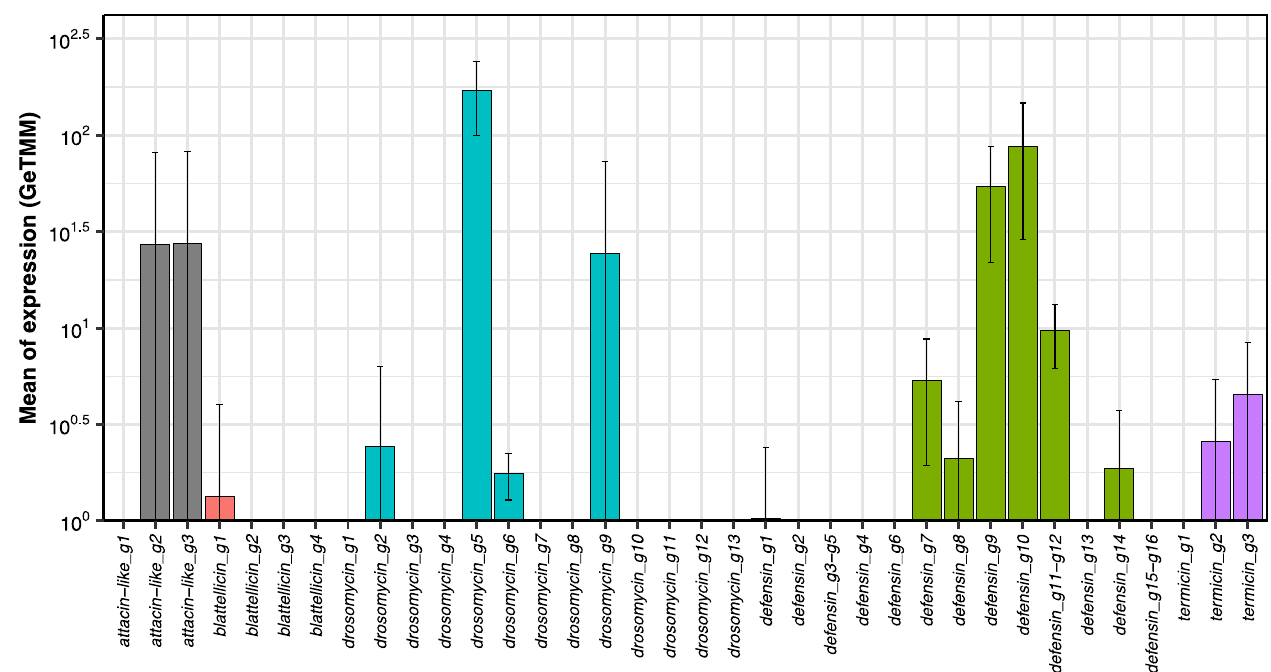
Figure 5. Expression of AMP genes in fat body of B. germanica . Means and standard deviations of normalized expression (GeTMM) of AMP genes. Graph bars are standard deviations. Y-axis is in log scale. The lower ends of the error bars are not shown below 10 0 . Color codes for gene families are: attacin-like (gray), blattellicin (pink), drosomycin (cyan), defensin (green) and termicin (violet).